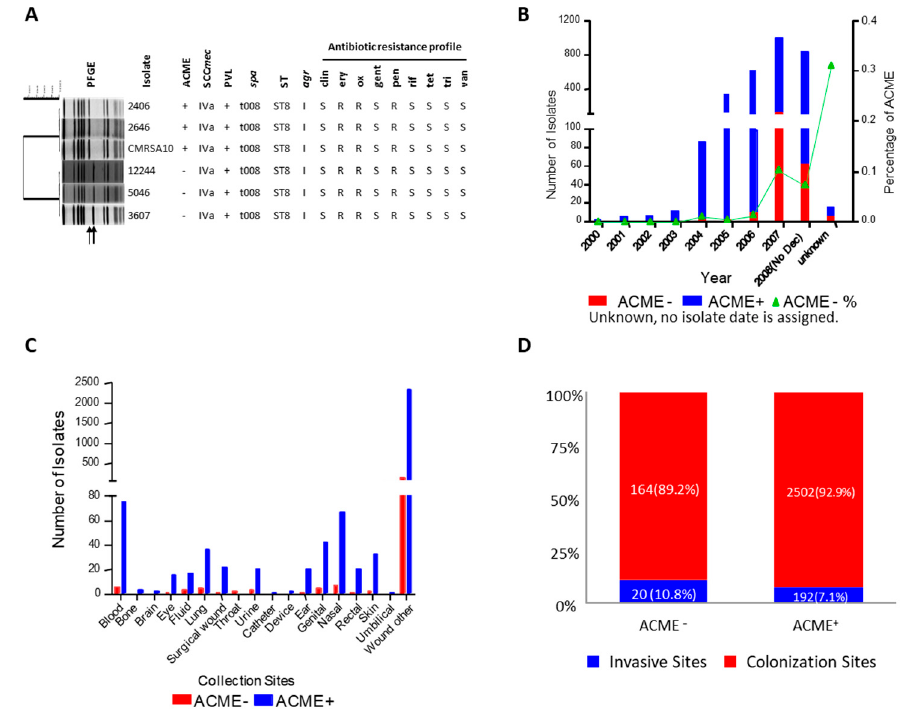
Figure 9. Epidemiological features of USA300 ACME + / - clinical isolates in AHS-Calgary. ( A ) PFGE fingerprint, genotypic and phenotypic characteristics of ACME + / − USA300 clinical isolates